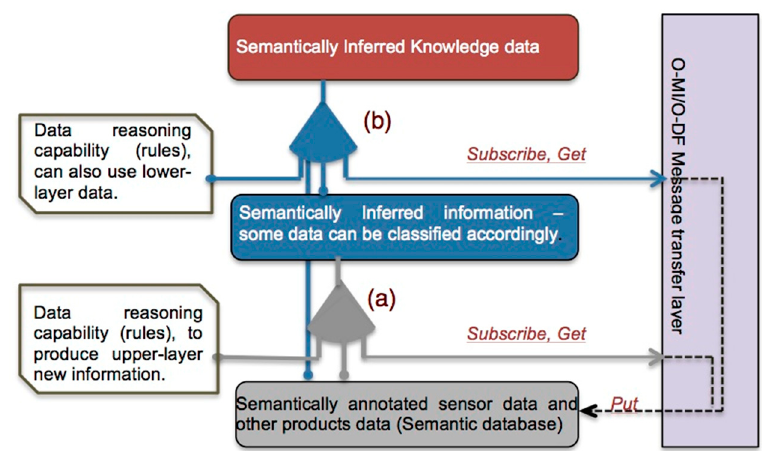
Figure 6. Semantic info-node agent architecture.